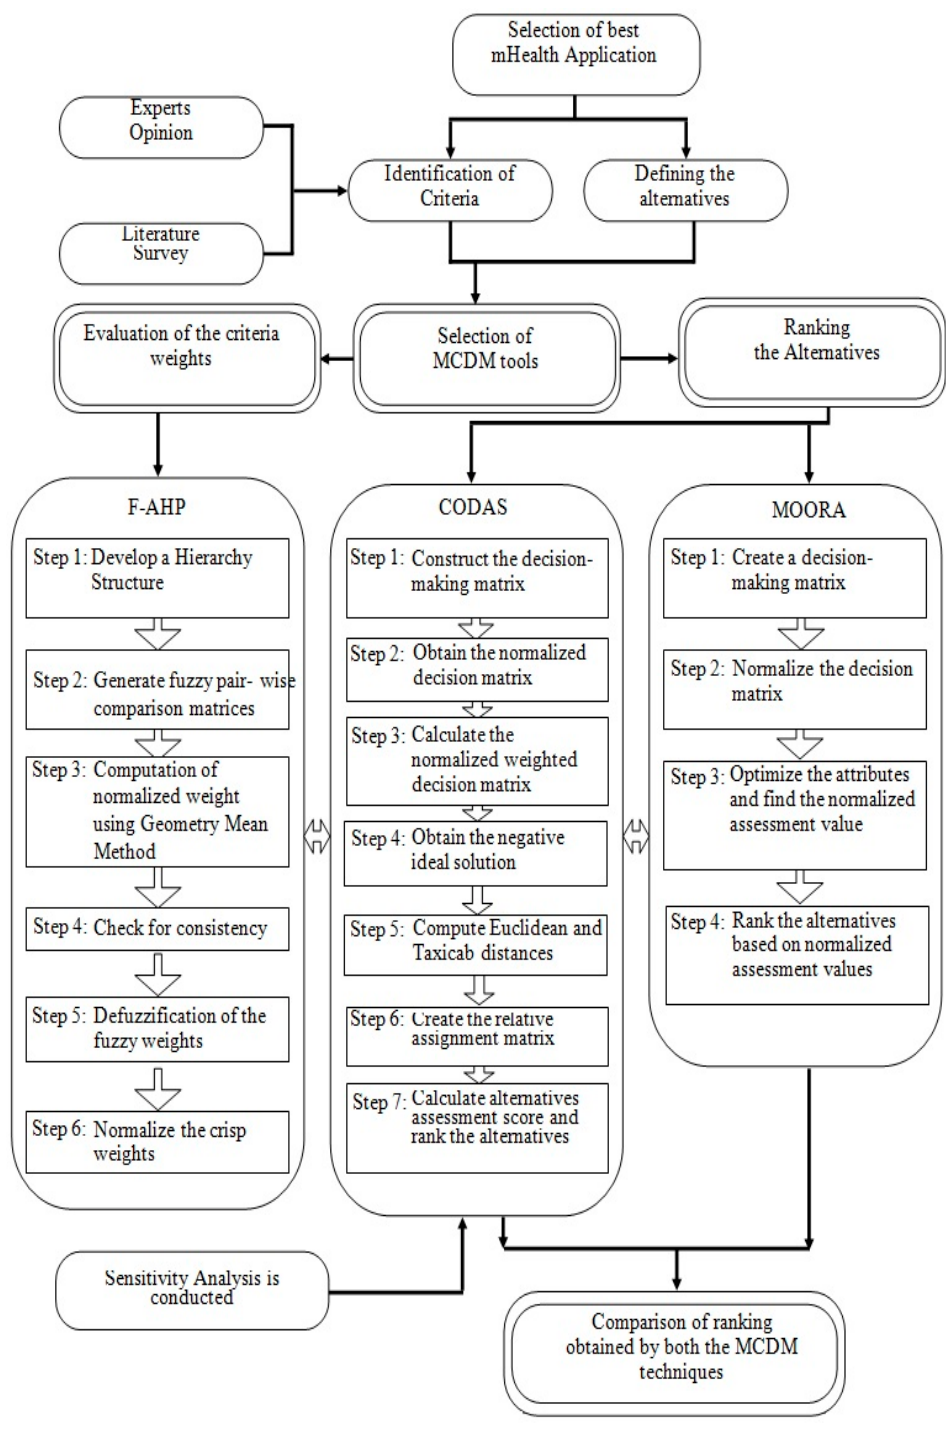
Figure 1. Proposed Hybrid Models.